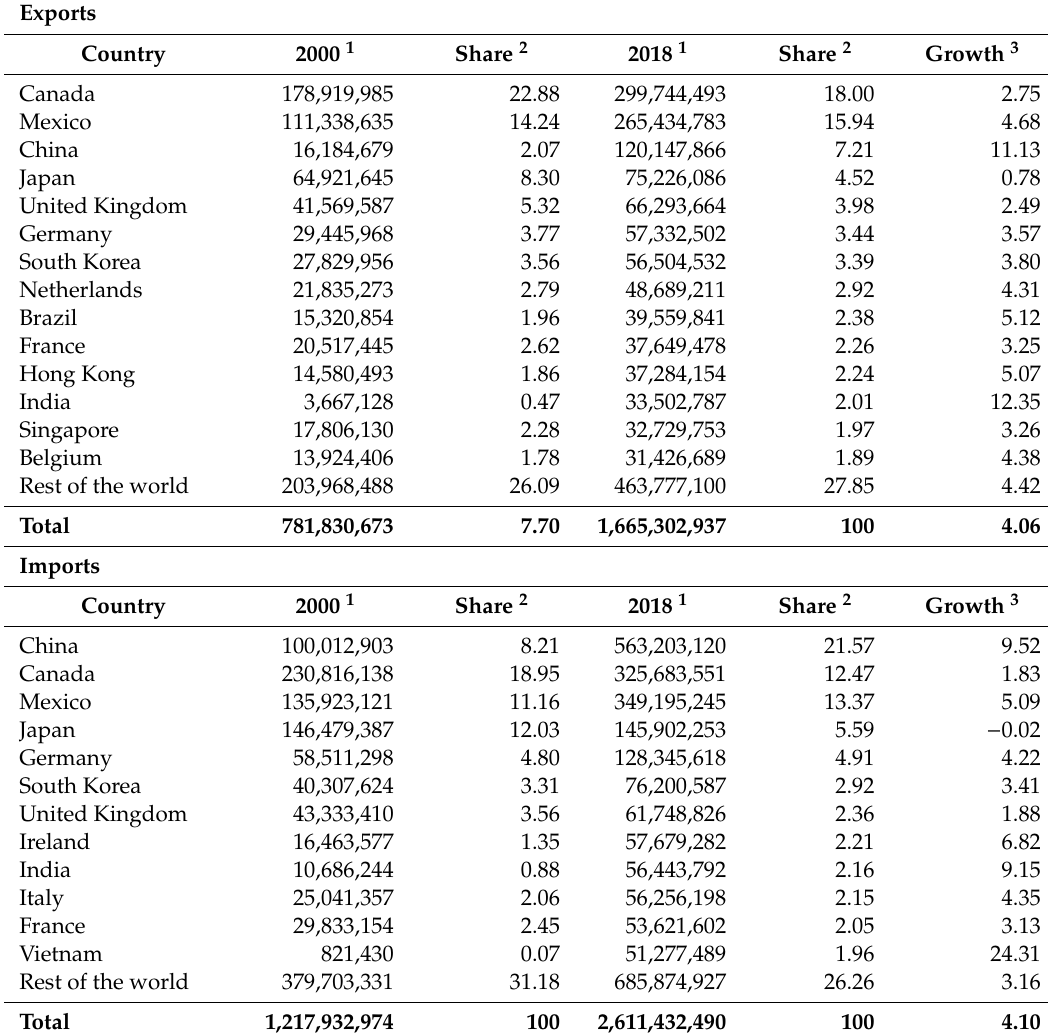
Table 3. Exports and Imports by Country: United States